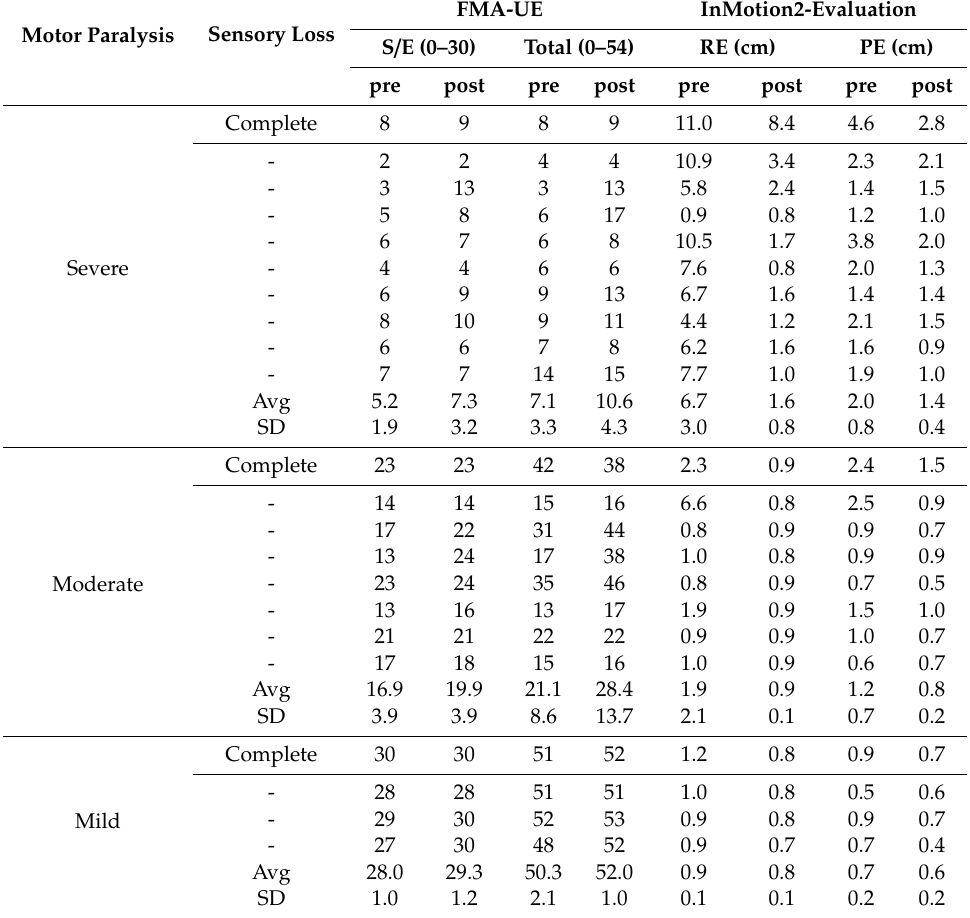
Table 2. The upper-extremity subscale of Fugl–Meyer Assessment (FMA-UE) and InMotion2-evaluation scores in pre- and post-robot